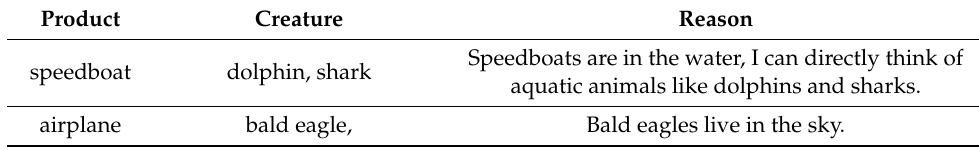
Table 4. Product using environment- creature habitat reasoning (20 times).